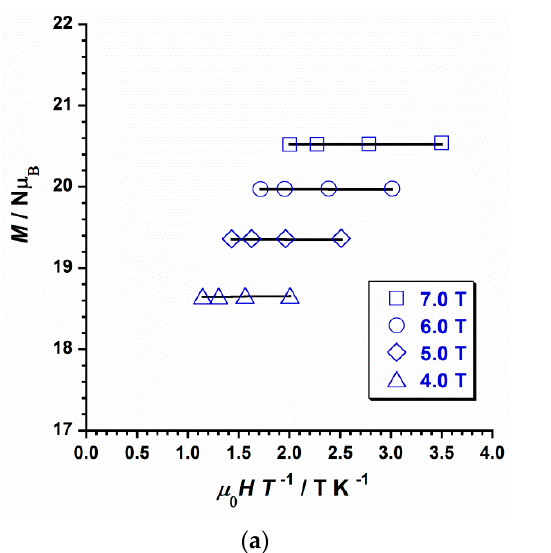
Figure 6. Plot of energy versus total spin state, extracted from the isotropic simulation of the susceptibility data for 1 ( a ) and 2 ( b ).